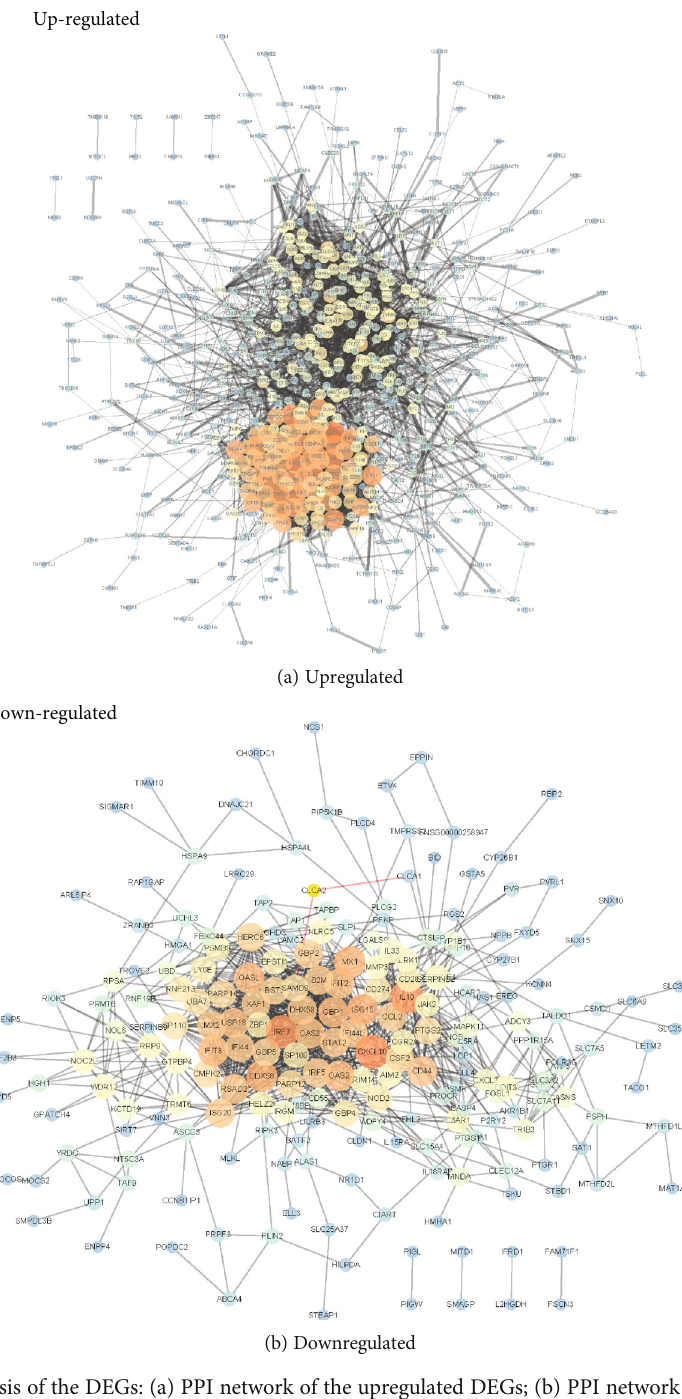
Figure 6: PPI network analysis of the DEGs: (a) PPI network of the upregulated DEGs; (b) PPI network of the downregulated